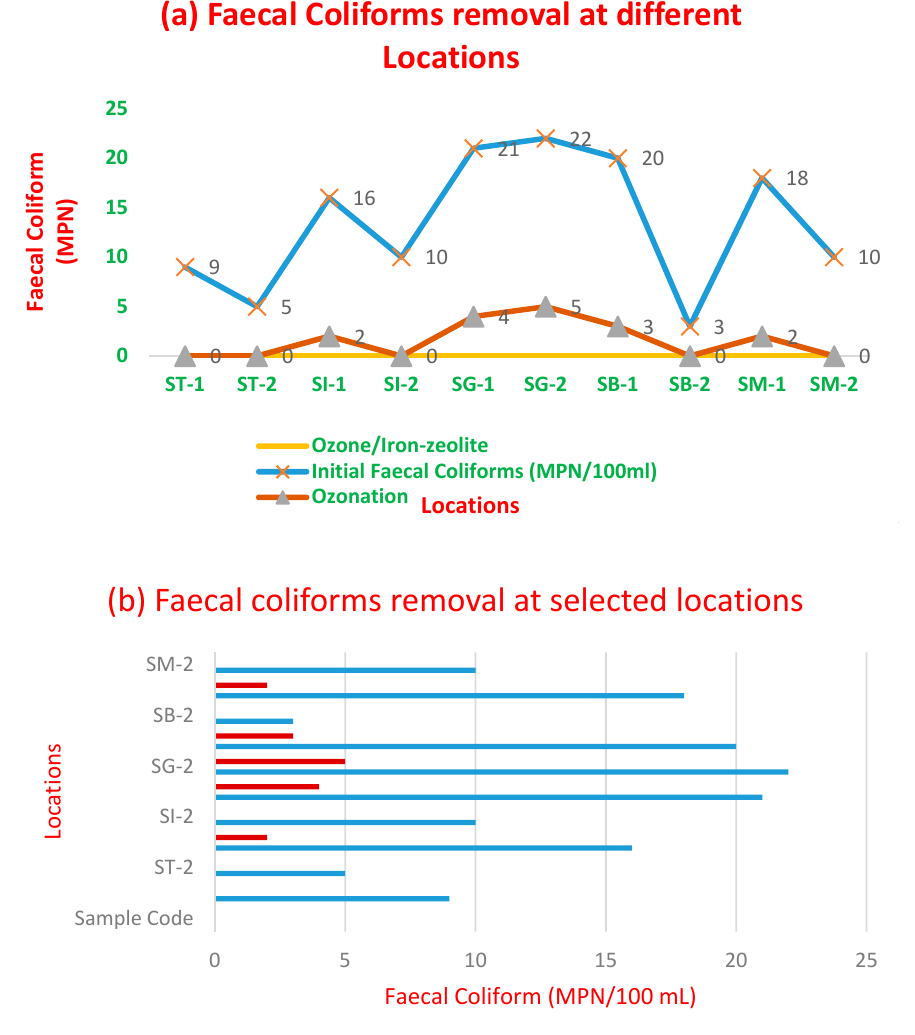
Figure 7. Comparison between O 3 and O 3 /Fe-ZA in terms of faecal coliforms removal from drinking water at selected locations of Lahore, Pakistan (ozone dose = 0.2 mg/min, Fe-ZA dose =10 g/L, pH = 8.1 ± 0.3, volume = 1 L, time = 30 min, T = 33 ± 2 °C).